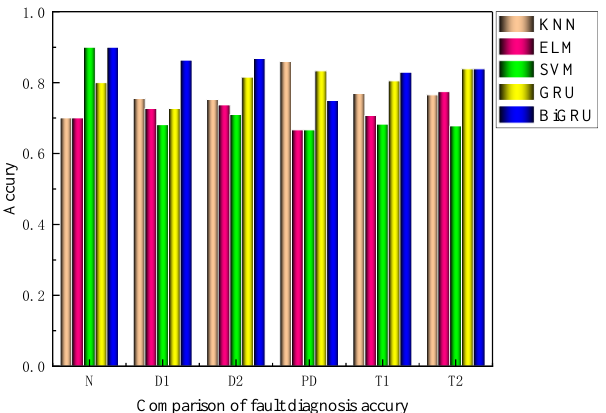
Figure 18. Diagnostic accuracy of different models.